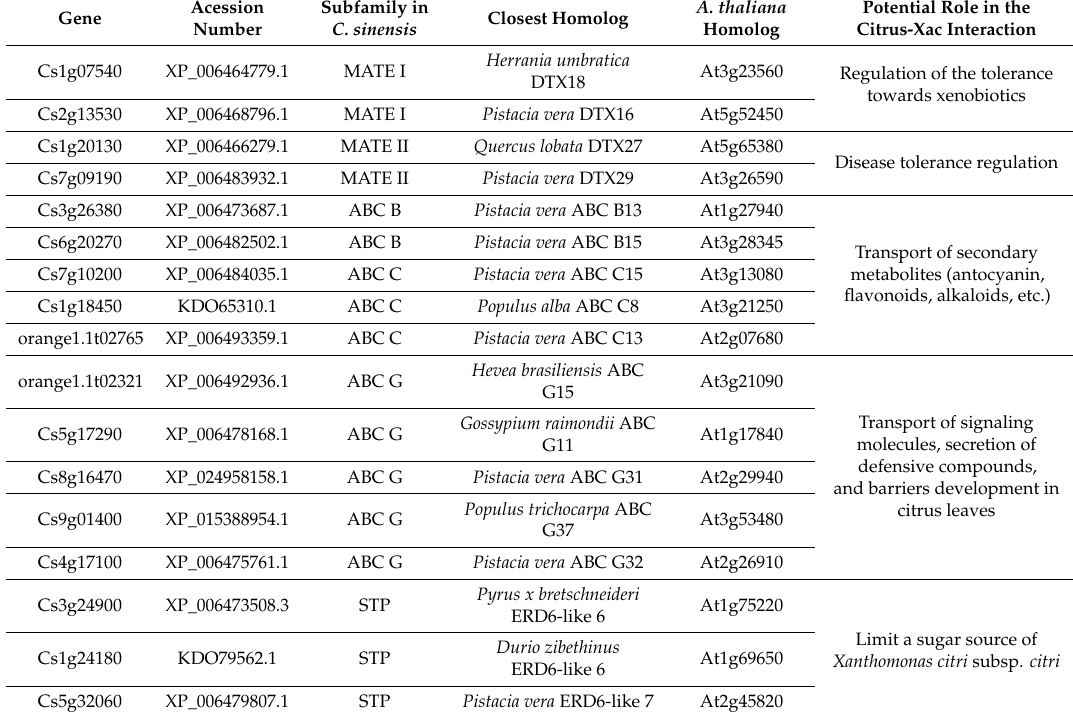
Table 1. Promising candidates for further exploitation based on their potential role in the Citrus-Xac